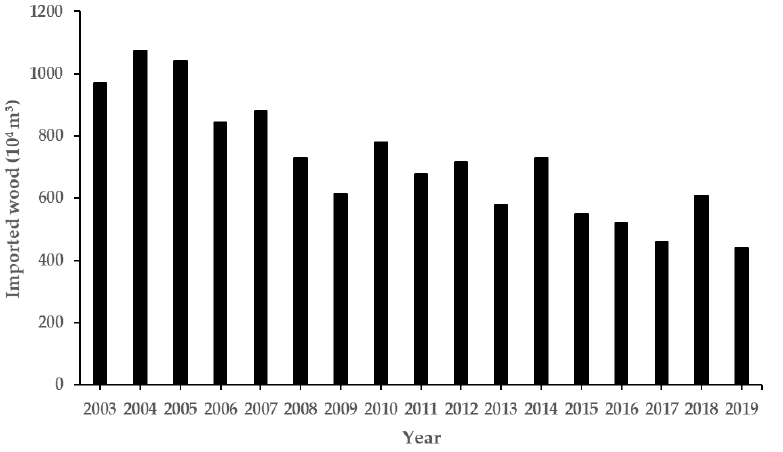
Figure 1. Imported amounts of wood in Taiwan since 2003 [14].